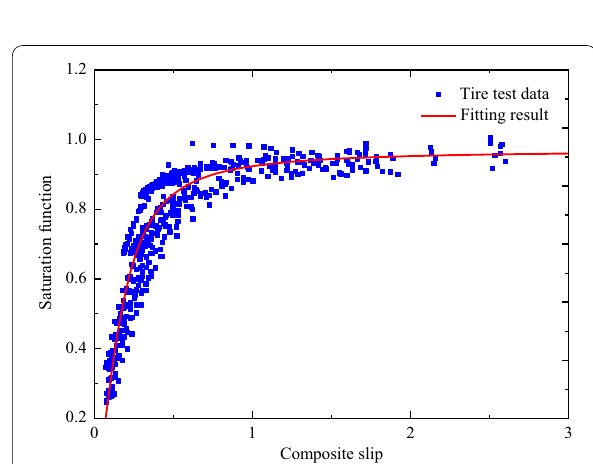
Figure 2 Comparison between the experimental results and the simulation results of the tire force saturation